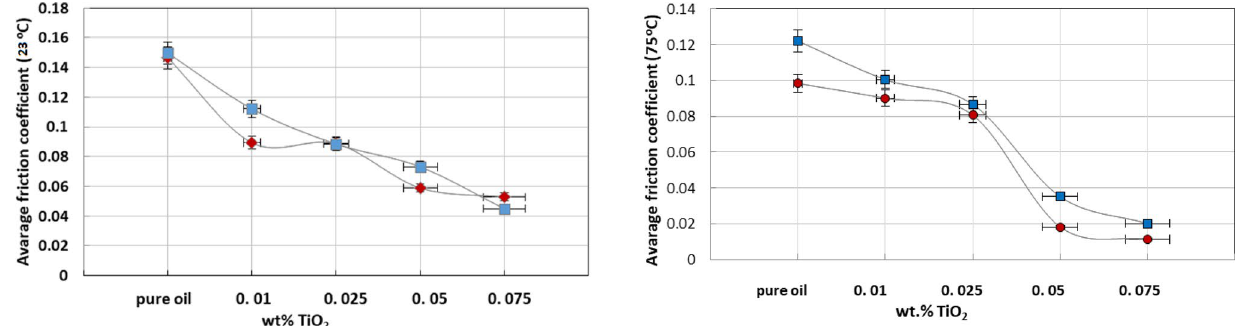
Figure 14. Average coefficient of friction (COF) for different additive amount of TiO 2 at RT (23 °C) and 75 °C and COF in steady state after rubbing